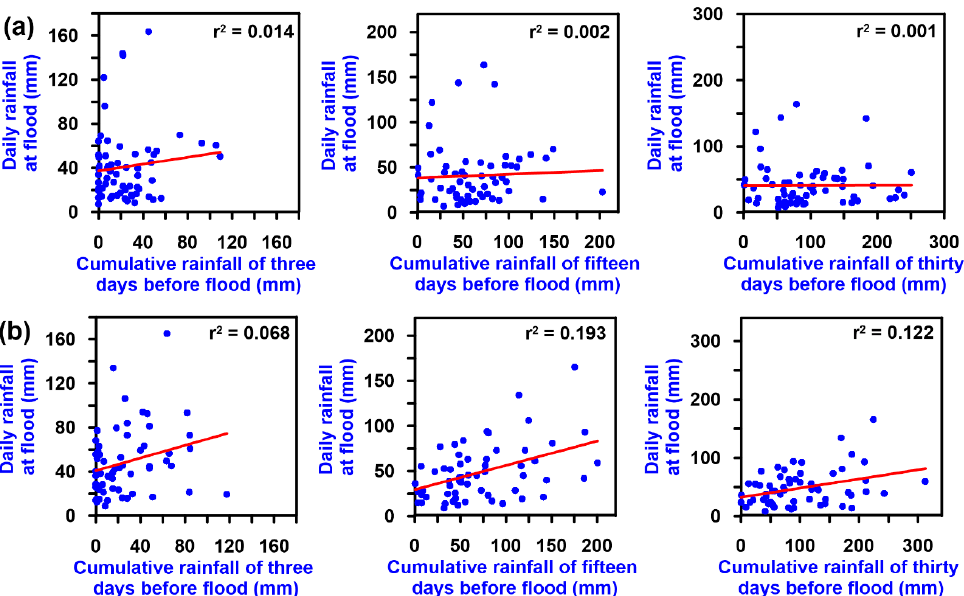
Figure 5. Daily triggering precipitation versus antecedent rainfalls over three, 15, and 30 days at Metaponto ( a ) and Policoro ( b ).